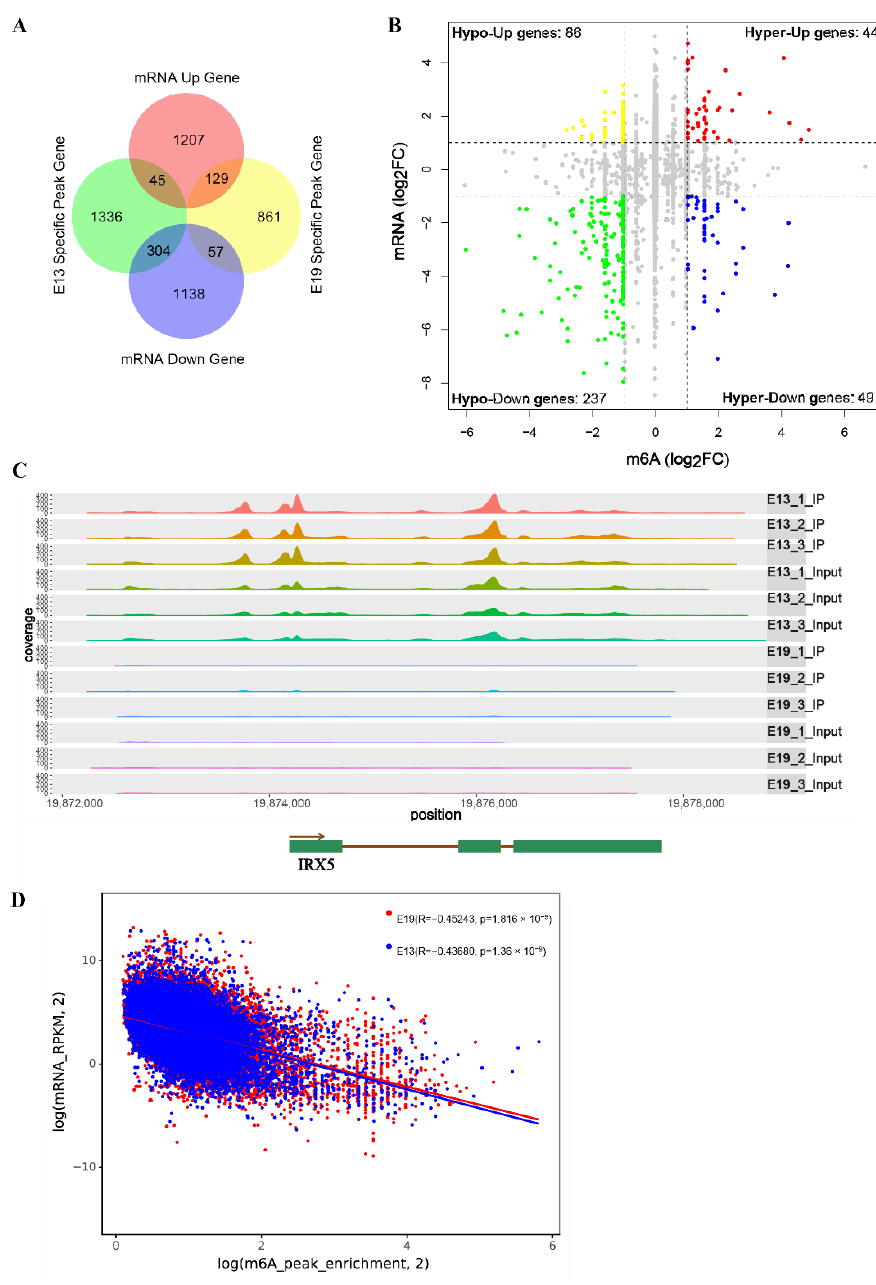
Figure 5. Conjoint analysis of MeRIP-seq and mRNA-seq data. ( A ) Venn diagram of the m6A peaks and DEGs in E19 and E13. ( B ) Distribution of genes with |log2FC| > 1 in both MeRIP-seq and RNA-seq data in E19 and E13. ( C ) The m6A abundances in IRX5 mRNA for the E19 and E13 groups. The m6A peak, which was significantly higher in E19 than in E13, is shown in the black rectangle ( p < 0.05 and |log2FC| > 1). ( D ) A plot of m6A peak abundance and mRNA expression in E19 and